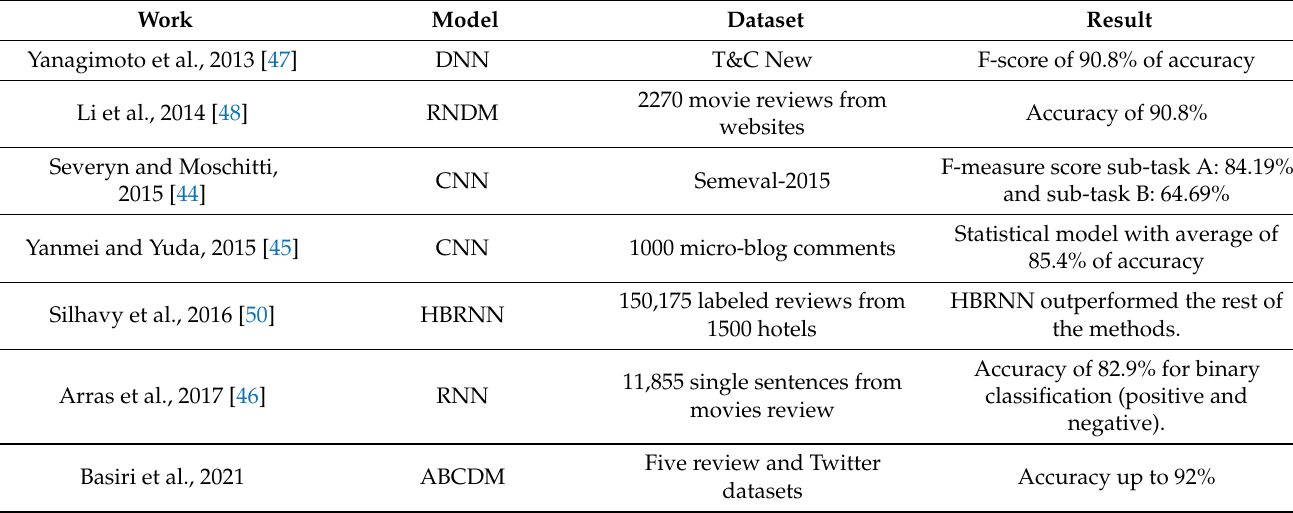
Table 1. Deep Learning techniques and